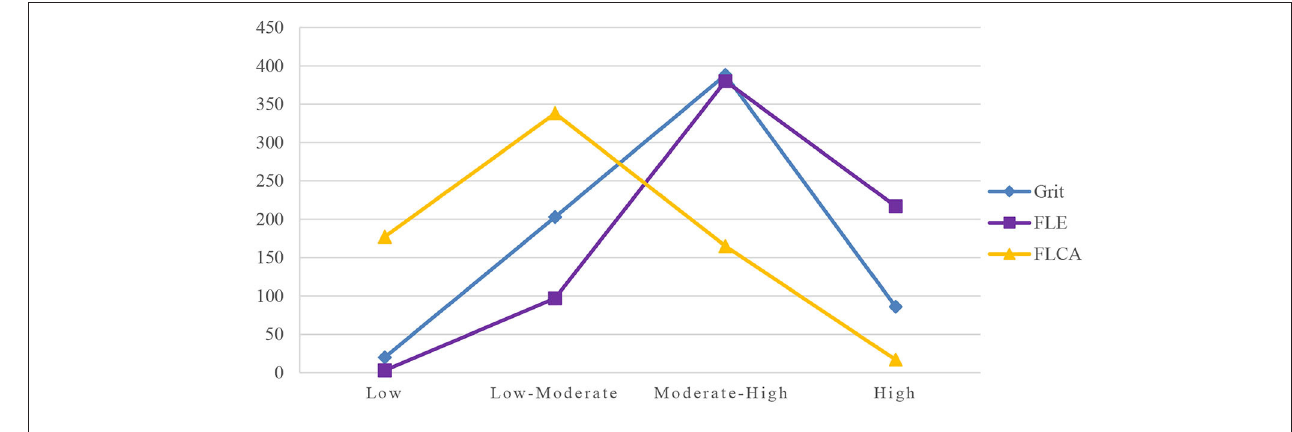
FIGURE 1 | The tendencies of Grit, FLE, and FLA levels.